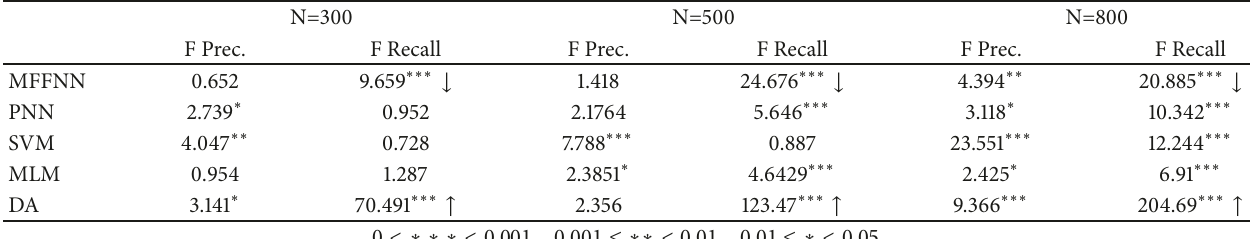
Table 7: The outcome of one-way ANOVA for mean comparison of each method for given sample sizes. The downward (upward) arrow shows a strictly decreasing (increasing) trend. N=300 N=500 N=800 F